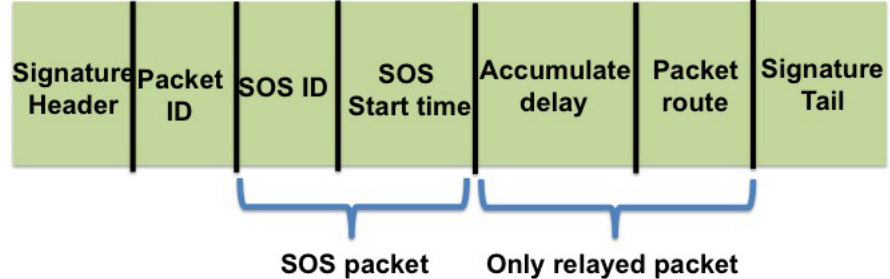
Figure 2. Structure of transmitted